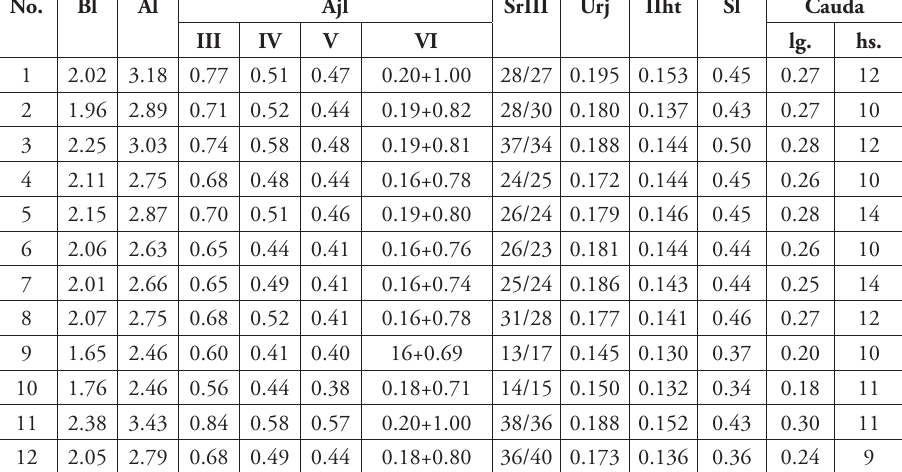
No. 1 is the holotype , others are paratypes ; ns. 1–3 and 11 sample no. i 515a; ns. 4–8 and 12 sample